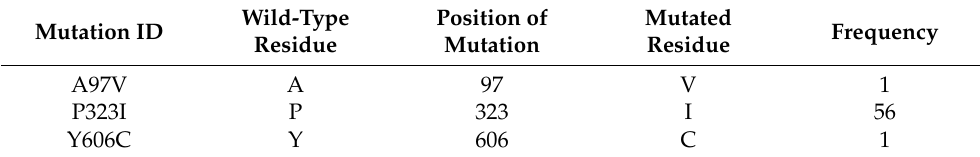
Table 2. Details of identified